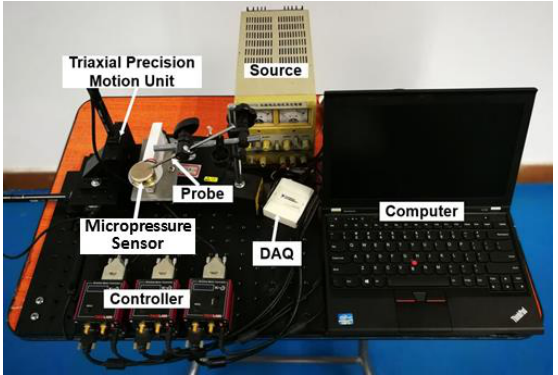
Figure 1. Microcontact force monitoring system based on a micropressure sensor.